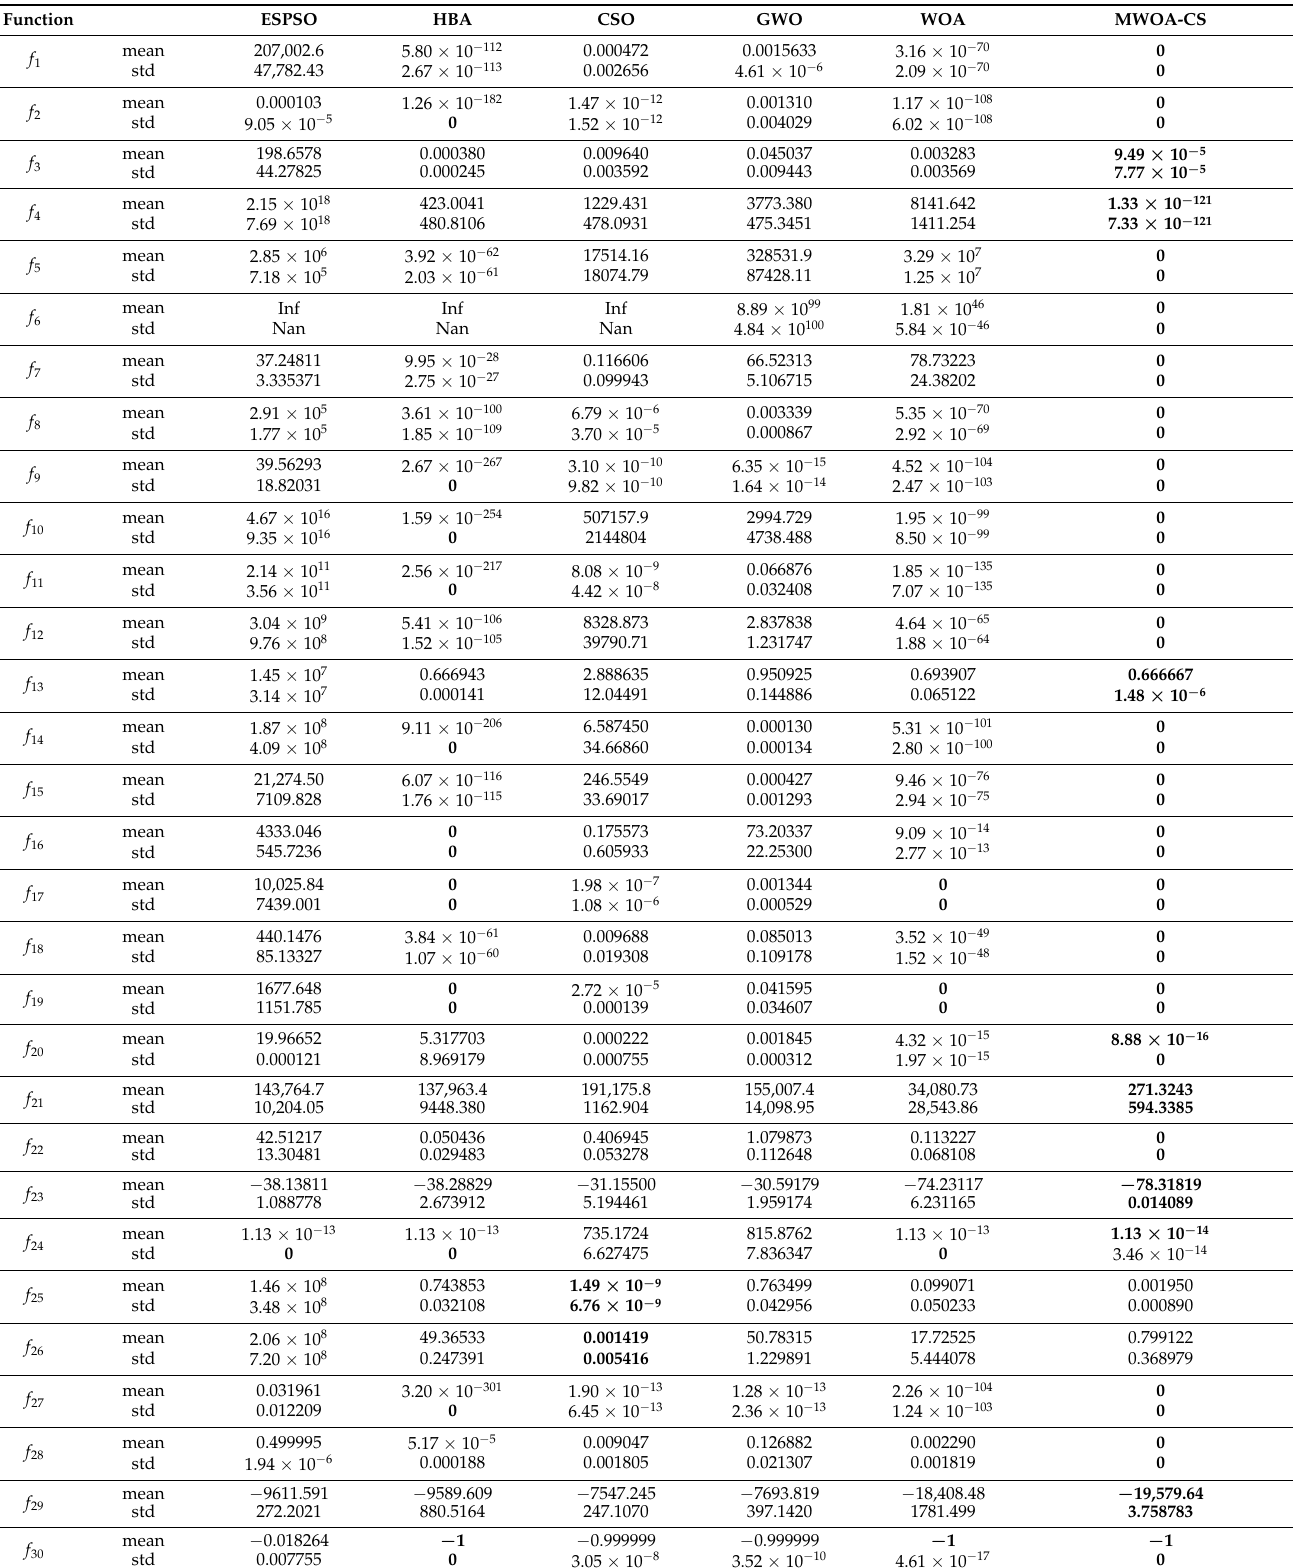
Table 4. Comparison results of algorithms for test problems with dim =